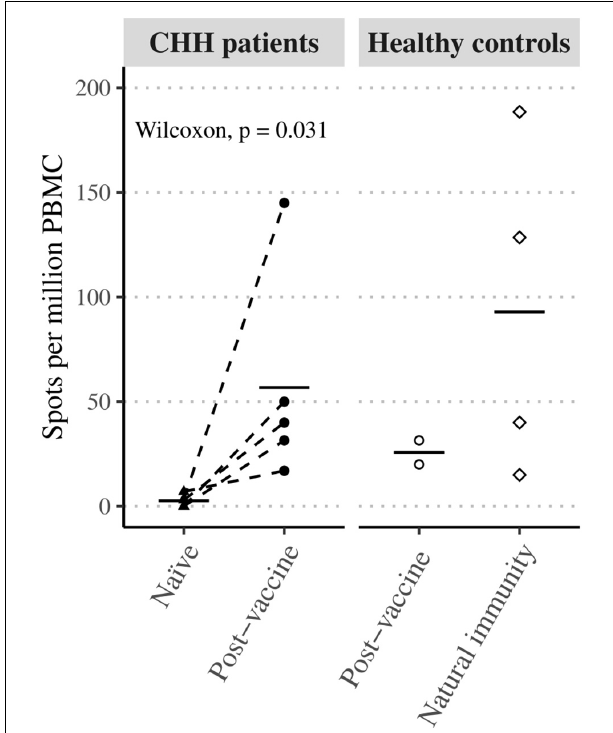
FIGURE 2 | Varicella zoster virus antigen response in CHH patient samples. Peripheral blood mononuclear cells of naïve and post-vaccine paired patient samples showed statistically significant induction of cellular immunity in interferon- γ elispot antigen assay. The level of induction (mean, black lines) was similar to a single healthy